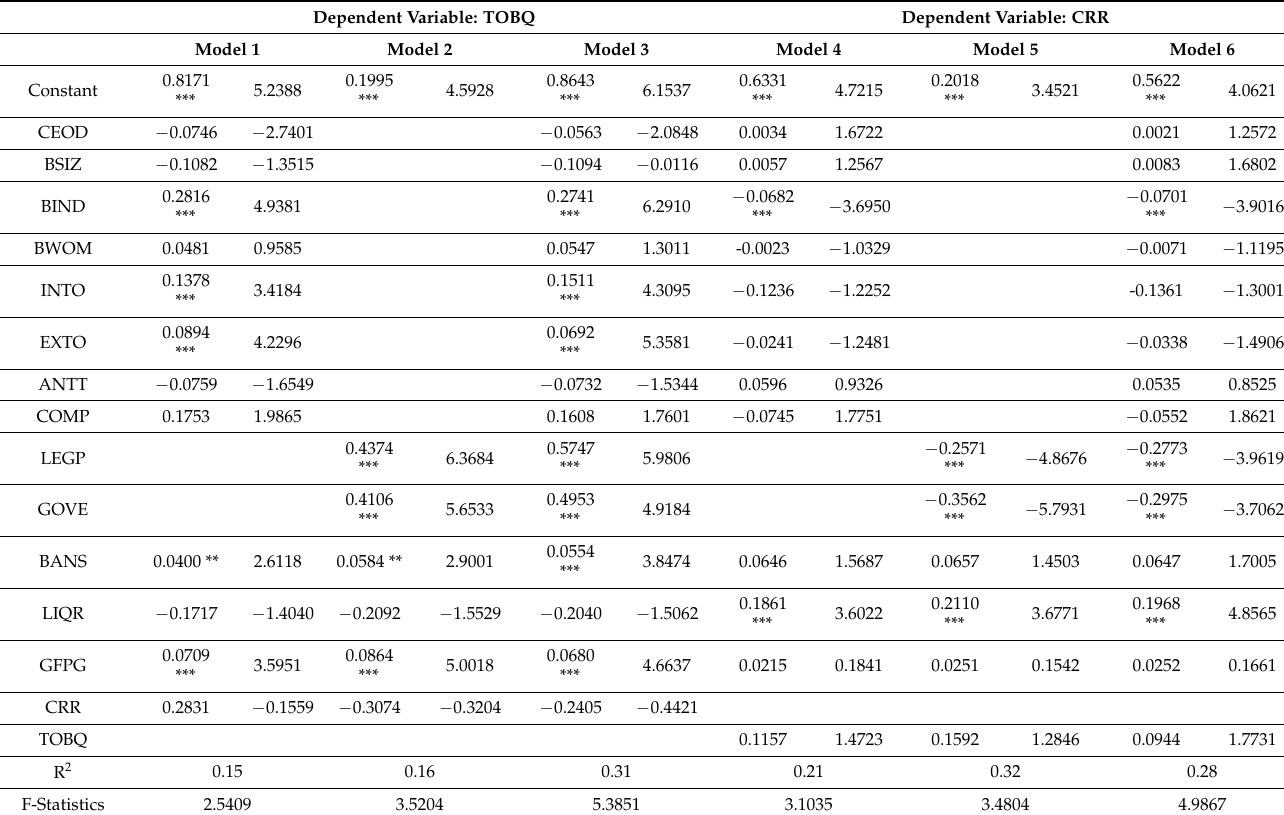
Table 8. Regression analysi—Two- Stage Least Squares